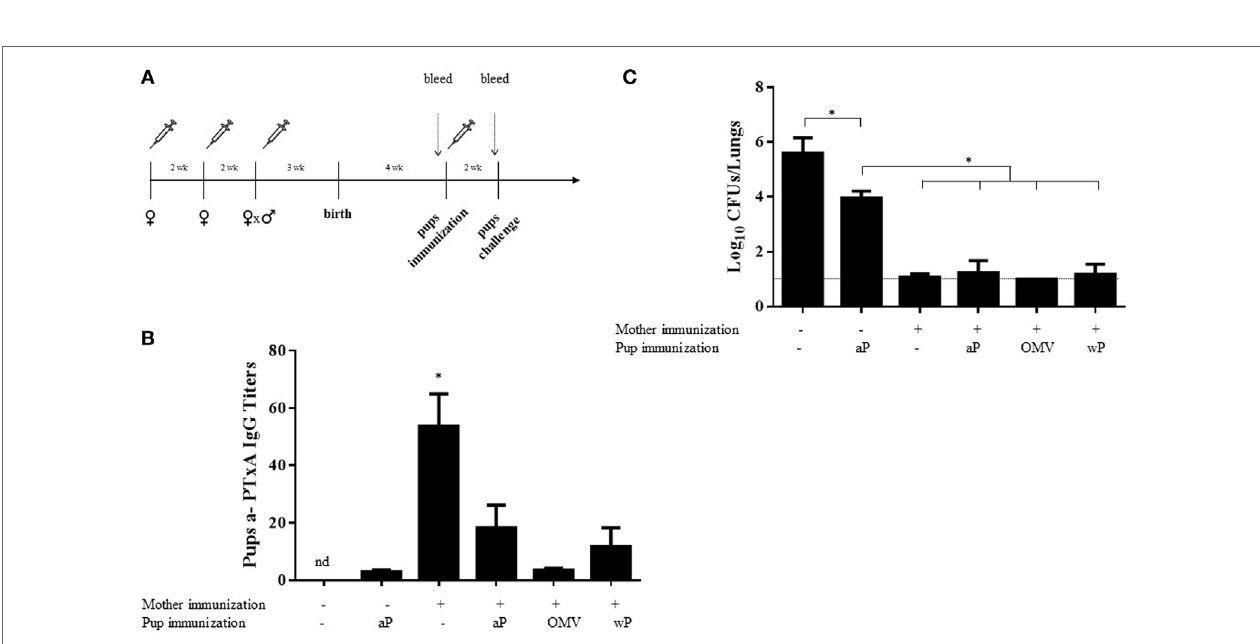
FigUre 6 | Effect of heterologous mother–pup vaccination on protection against Bordetella pertussis challenge. (a) Schematic representation of vaccination and challenge protocols. Female mice were immunized with three doses of commercial aP vaccine on days 0 and 14; mated with male mice; and when the vaginal plug was detected, a third aP dose was administered. Four weeks after birth, the offspring received either no vaccine ( n = 8) or one dose of the aP, OMV, or wP vaccine ( n = 8 in each group), as indicated below the abscissas of panels (B,c) . Two weeks later, the pups were challenged with B. pertussis and the bacterial burden in the lungs measured 7 days after challenge. Pups born to vaccinated or non-vaccinated mothers and receiving no postnatal vaccine served as controls. The pups ( n = 5 for each group) were bled and the anti-pertussis toxin (a-PTxA) IgG titers determined 1 day before the challenge as designated by the dotted vertical arrow. (B) The titers, plotted on the ordinate , are expressed as the geometric mean of the data from each group specified on the abscissa . * p < 0.05 pups born to immunized mother versus others groups, and the nd signifies not detected. (c) In the figure, the number of bacteria recovered from the mouse lungs, expressed as the log 10 (mean CFUs ± SD per lung), is plotted on the ordinate for each group indicated on the abscissa . * p < 0.05 for negative control versus other groups, and aP-immunized pups born to non-immunized mother versus others groups. The dotted horizontal line marks the lower limit of detection. Of the three independent experiments that were performed, the results from a single representative one is